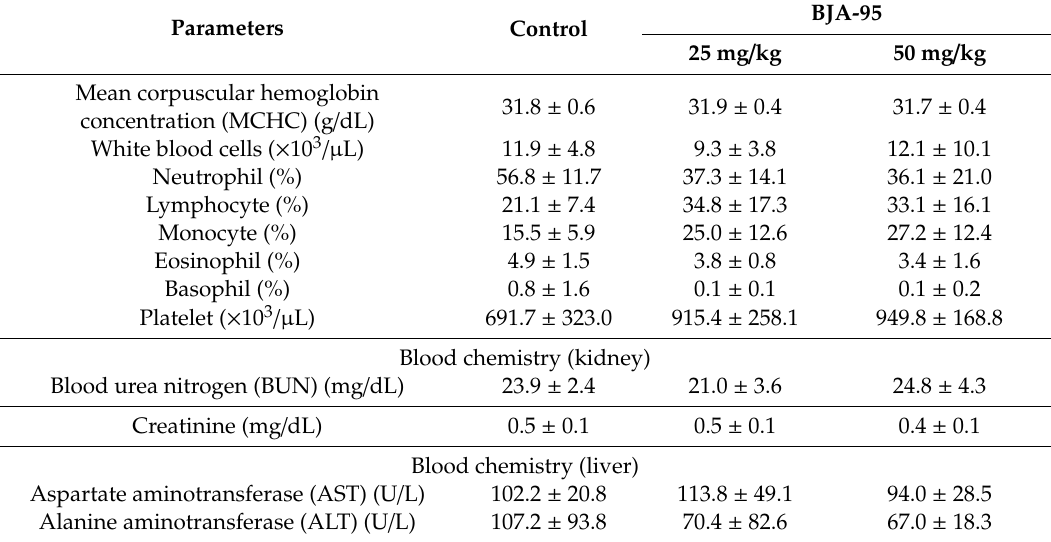
Table 2. Complete blood count and blood chemistry of mice treated with BJA-95 compared with control.